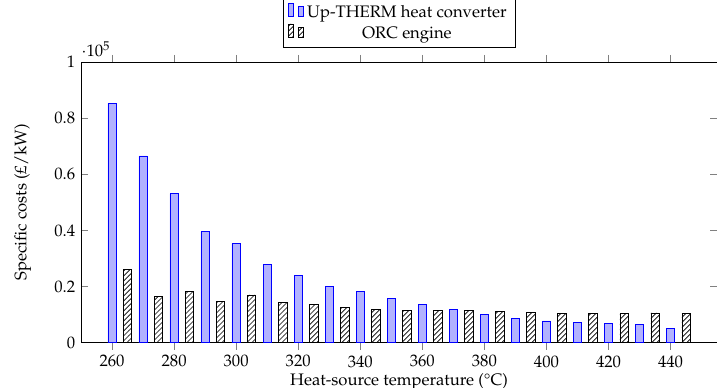
Figure 13. Specific costs for the Up-THERM heat converter and equivalent ORC engines for n -hexane as the working fluid at different heat-source temperatures.